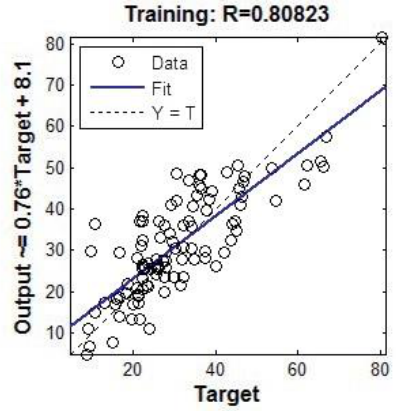
Fig. 16. Relationship between Target and Output Values in Training Step of ANN Modeling with 24 Hidden Neurons.